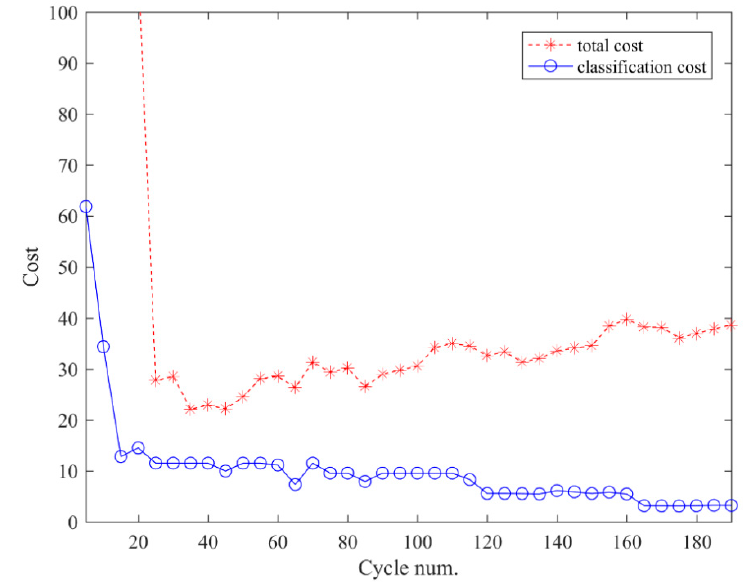
Figure 11. Cost versus cycle number.